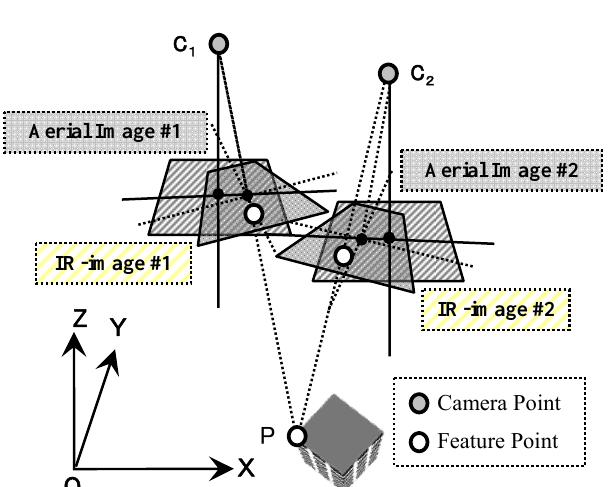
Figure 1. Flowchart of Proposed